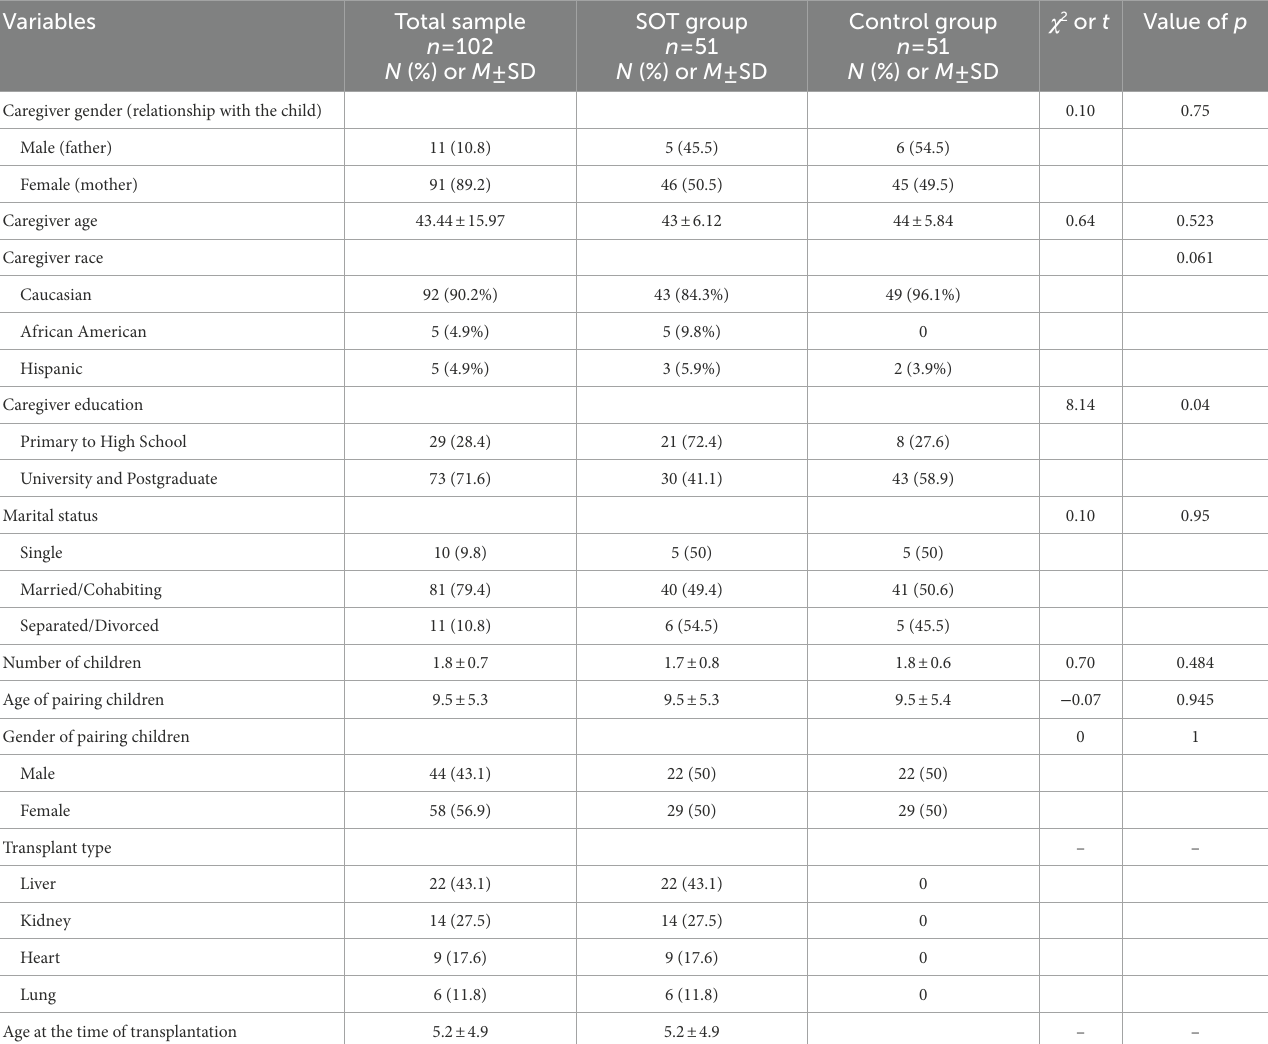
TABLE 1 Sociodemographic characteristics of the